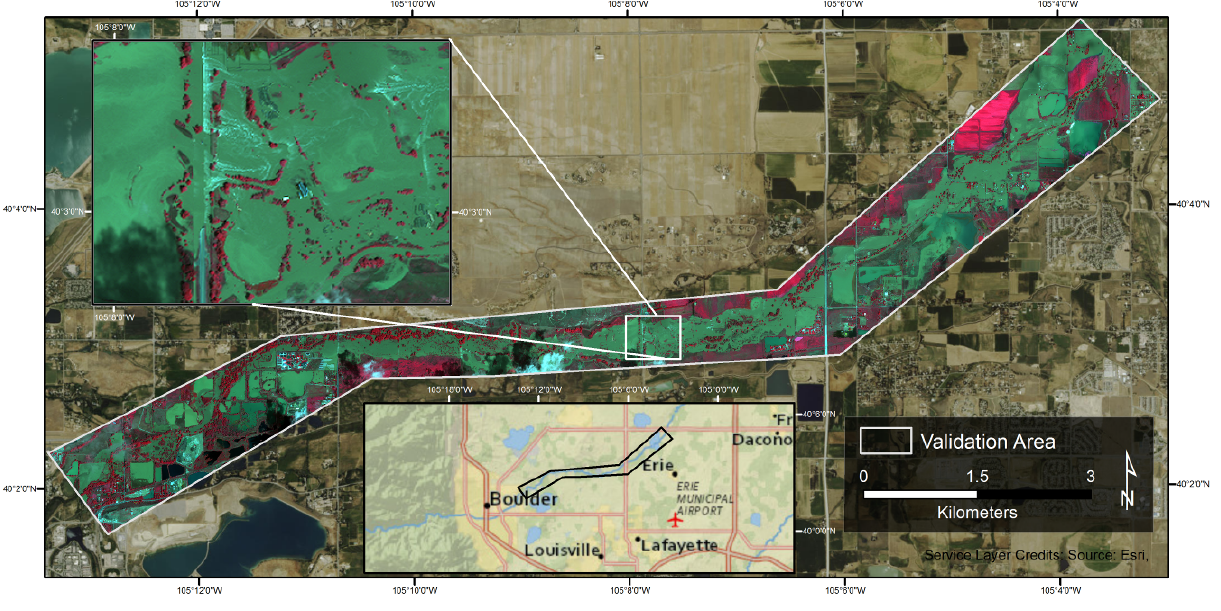
Figure 7. WorldView-2 image of Boulder Creek near peak flow of the 2013 event. The image is displayed in standard false color (NIR-R-G); within the validation area, water is blue-green or black, and vegetation is red. Inset shows flooding over roads as well as the inundated